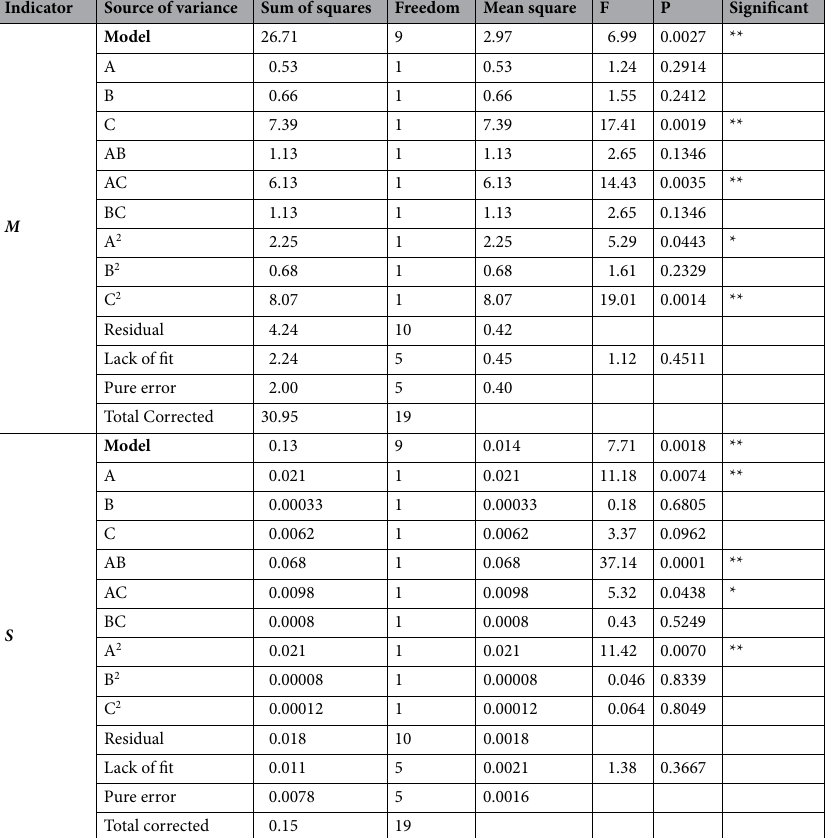
Table 4. ANOVA of regression model.